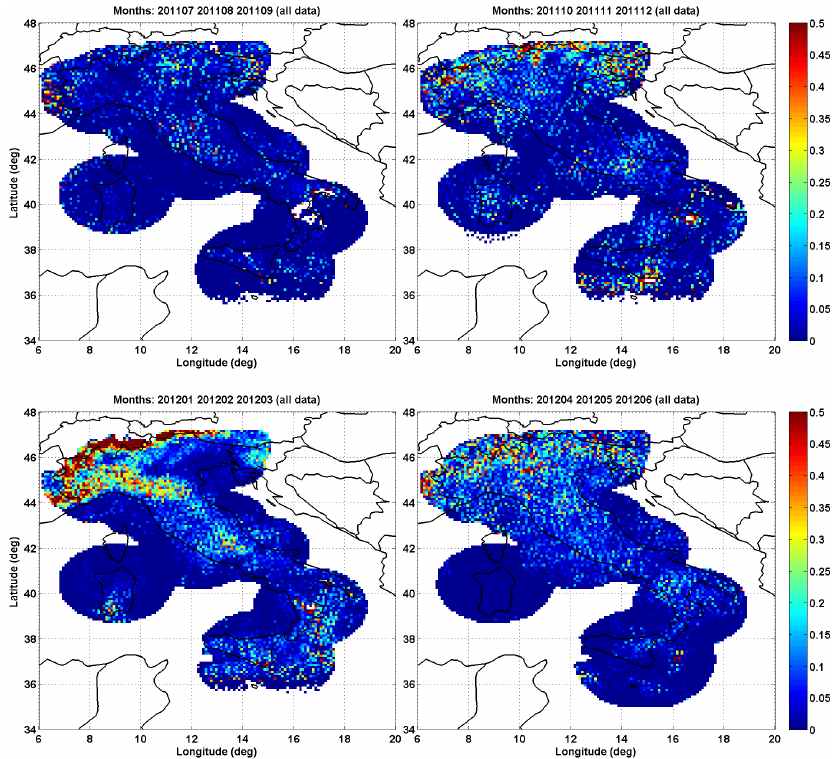
Fig. 11. As in Fig. 7 but with respect to RNC. Clockwise from top-left panel: summer, fall, winter, and spring. The vertical color bar is in Figure 11: As in Fig. 7 but with respect to RNC. Clockwise from top-left panel: Summer, Fall, 3 mmh − 1 . Winter, and Spring. The vertical color bar is in mm/h. 4